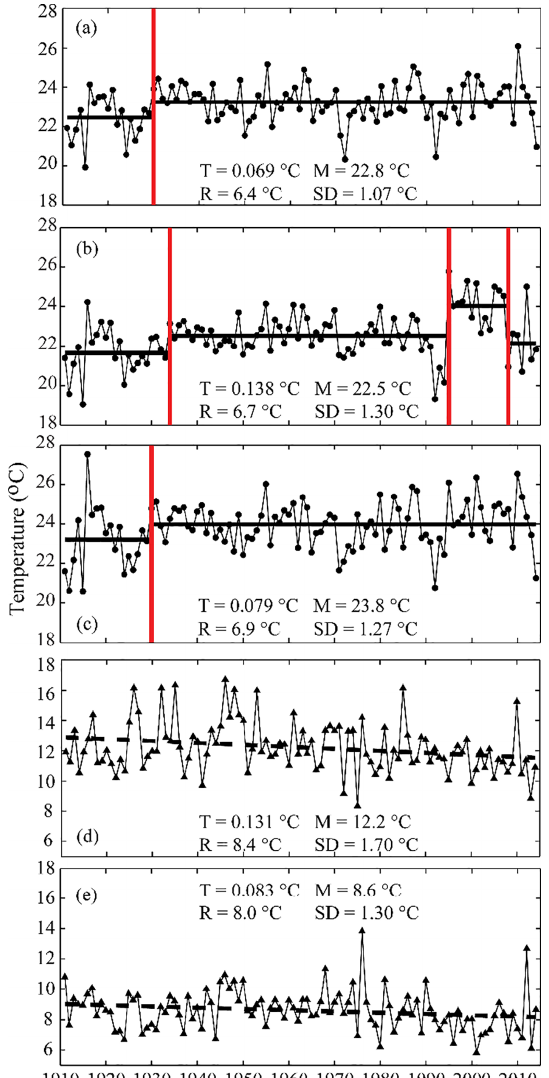
Figure 4. Mean summertime (15 July–15 August) epilimnetic tem- peratures for (a) Lake Mendota, (b) Fish Lake, and (c) Lake Wingra, and mean summertime (15 July–15 August) hypolimnetic temperatures for (d) Lake Mendota and (e) Fish Lake. In pan- els (a) , (b) , and (c) , solid red lines represent statistically significant ( p <0.05) locations of abrupt changes in epilimnion temperatures and solid lines represent mean temperatures for each period. In pan- els (d) and (e) , dashed lines represent the long-term trend over the period 1911–2014. T is the trend of water temperature change per decade, R is the range of temperatures, M is the mean tempera- ture, and SD is the standard deviation in temperatures for the study period. Epilimnion was defined as 0–10m depth for Mendota, 0– 5m for Fish, and the whole water column for Wingra based on sur- face mixed layer depth calculated using LakeAnalyzer (Read et al., 2011).